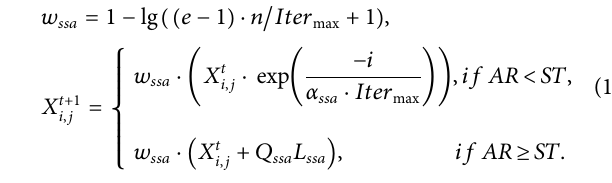
Frontiers in Energy Research |